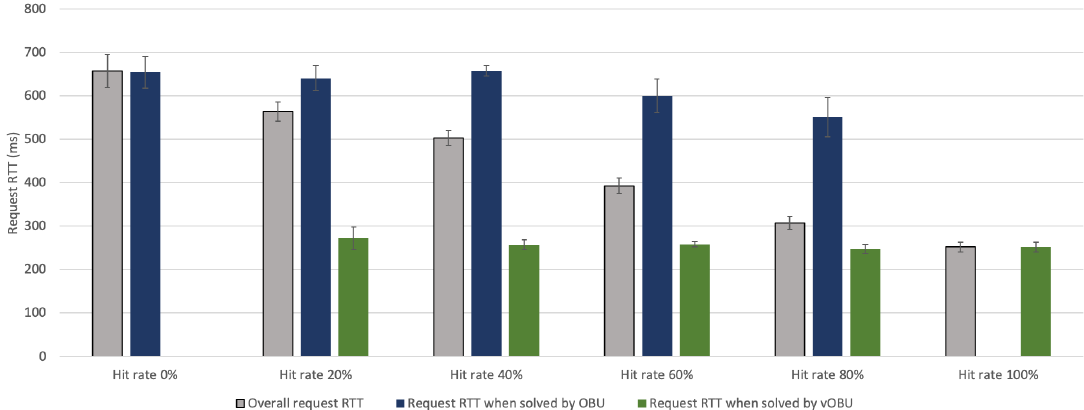
Figure 7. Round-trip delay time (RTT) values for requests when the vOBU hit rate varies from 0% to